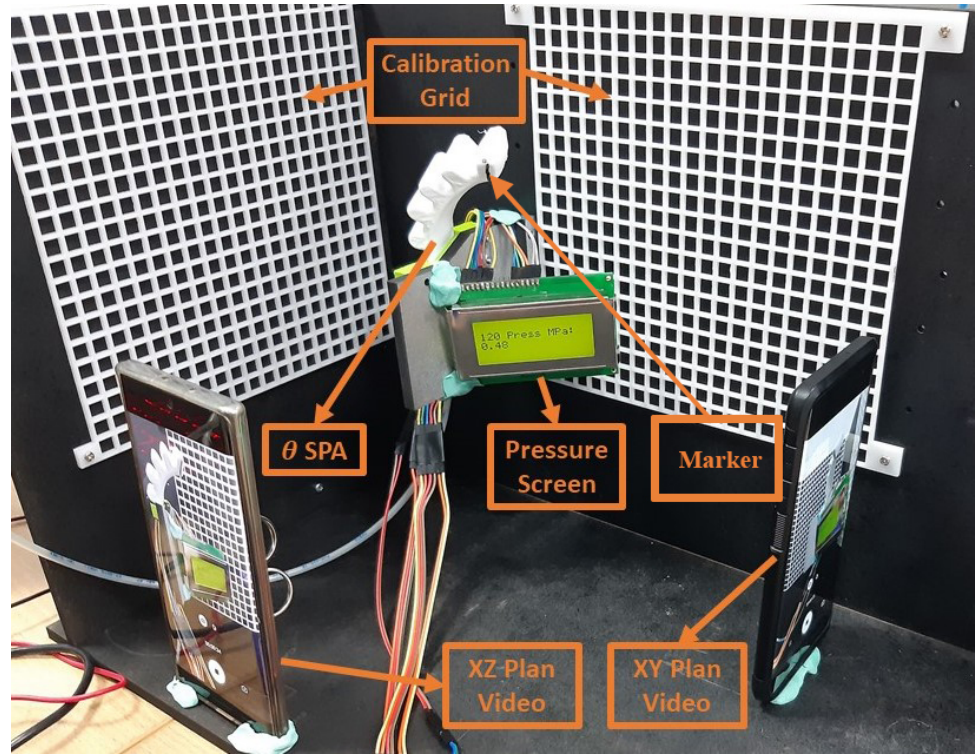
Figure 3. Experimental setup for the actuation of the SPA, including the calibration grid, cameras, and pressure visualization for data